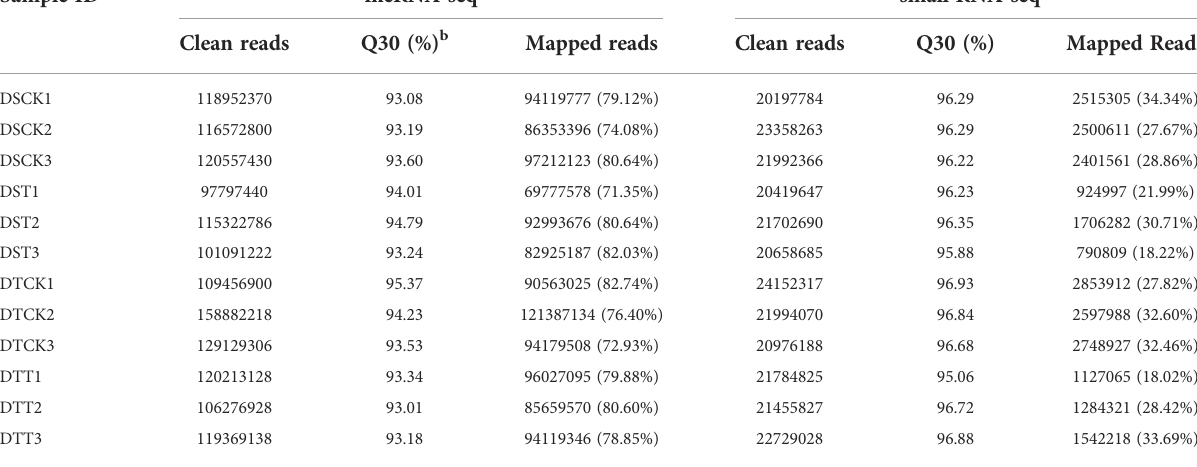
TABLE 1 Statistical table of sample sequencing data.